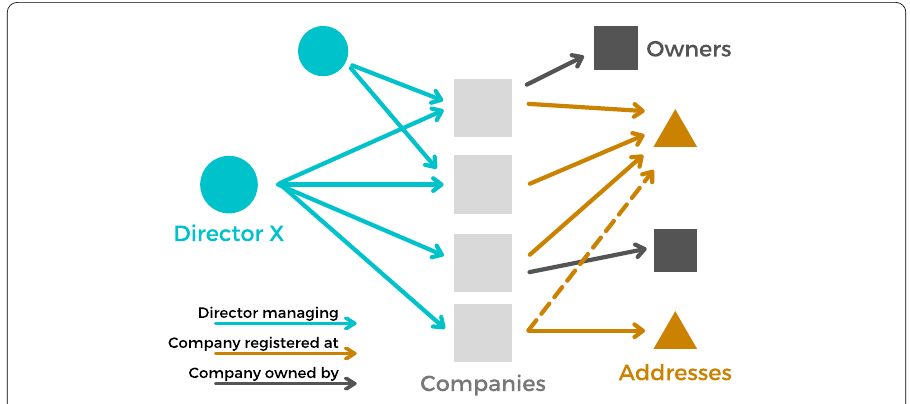
Figure 1 Schematic representation of the two-step ego-network of director X. Director X (middle turquoise circle) manages four companies (gray squares), registered at specific addresses (brown triangles). The companies can be owned by other companies or individuals (black squares), can have additional postal addresses (dashed brown line) and additional directors (top turquoise